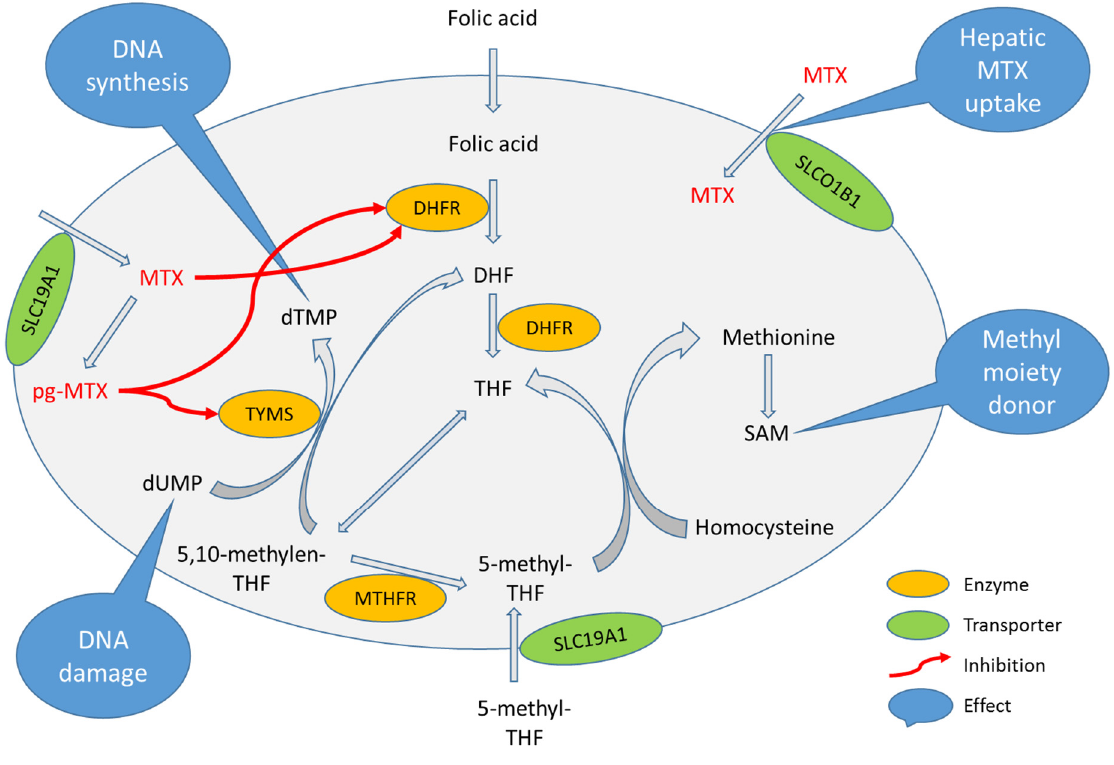
Figure 1. Folate metabolic pathway disrupted by methotrexate (MTX). MTX—methotrexate; pg-MTX—polyglutamated MTX; THF—etrahydrofolate; DHF—dihydrofolate; SAM—S-adenosyl